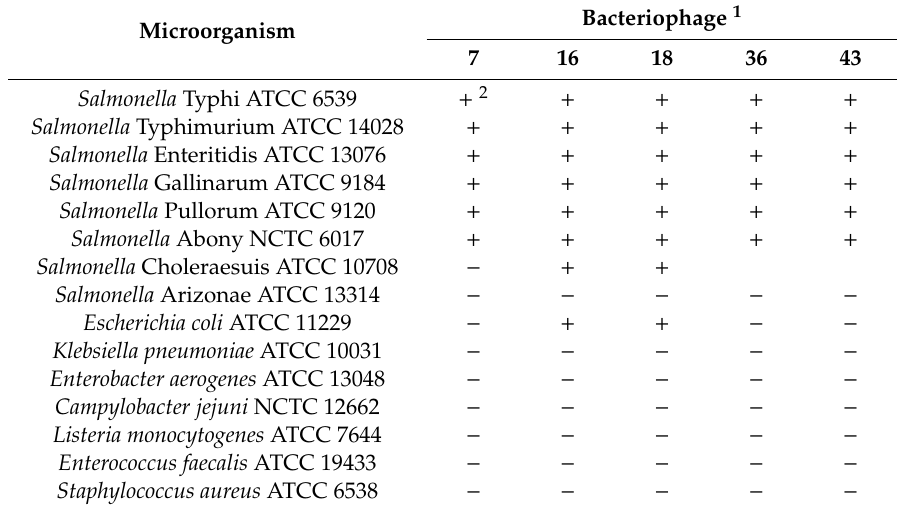
Table 1. Lytic spectrum of bacteriophages against Salmonella and other foodborne pathogens. Microorganism